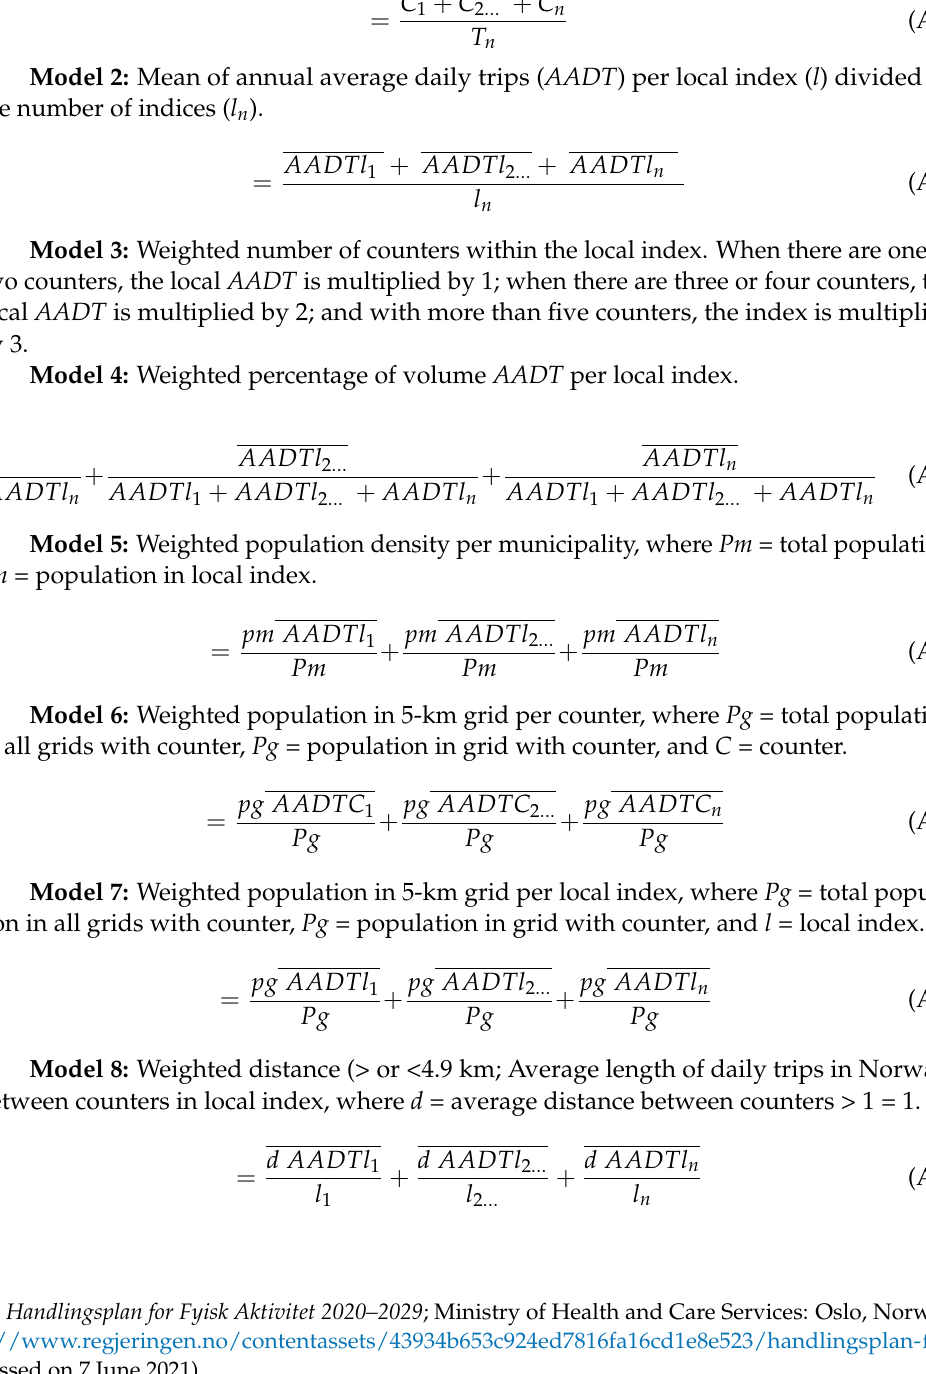
Model 1: The model is the mean of all counts ( C ) divided by the total number of counters: 79 ( T ).